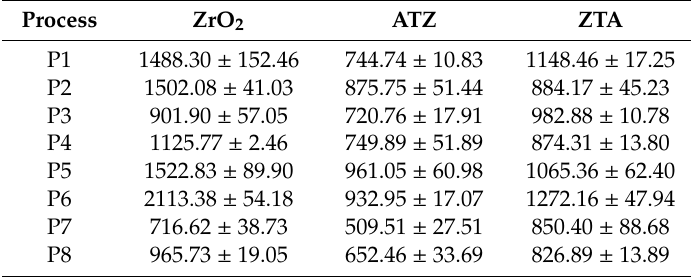
Table A1. Surface roughness, Sa (nm), per material of the ground dental threads.